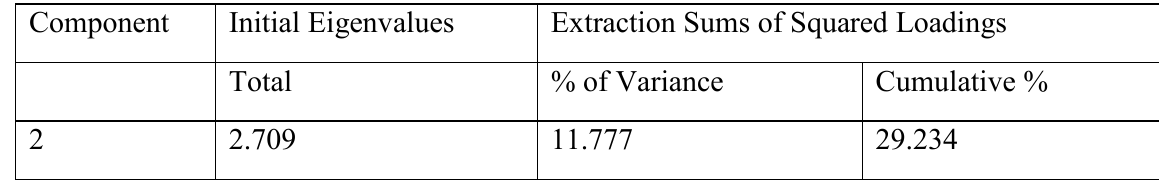
Table 1.25: Variance explained for Adaptive Resilience PC2